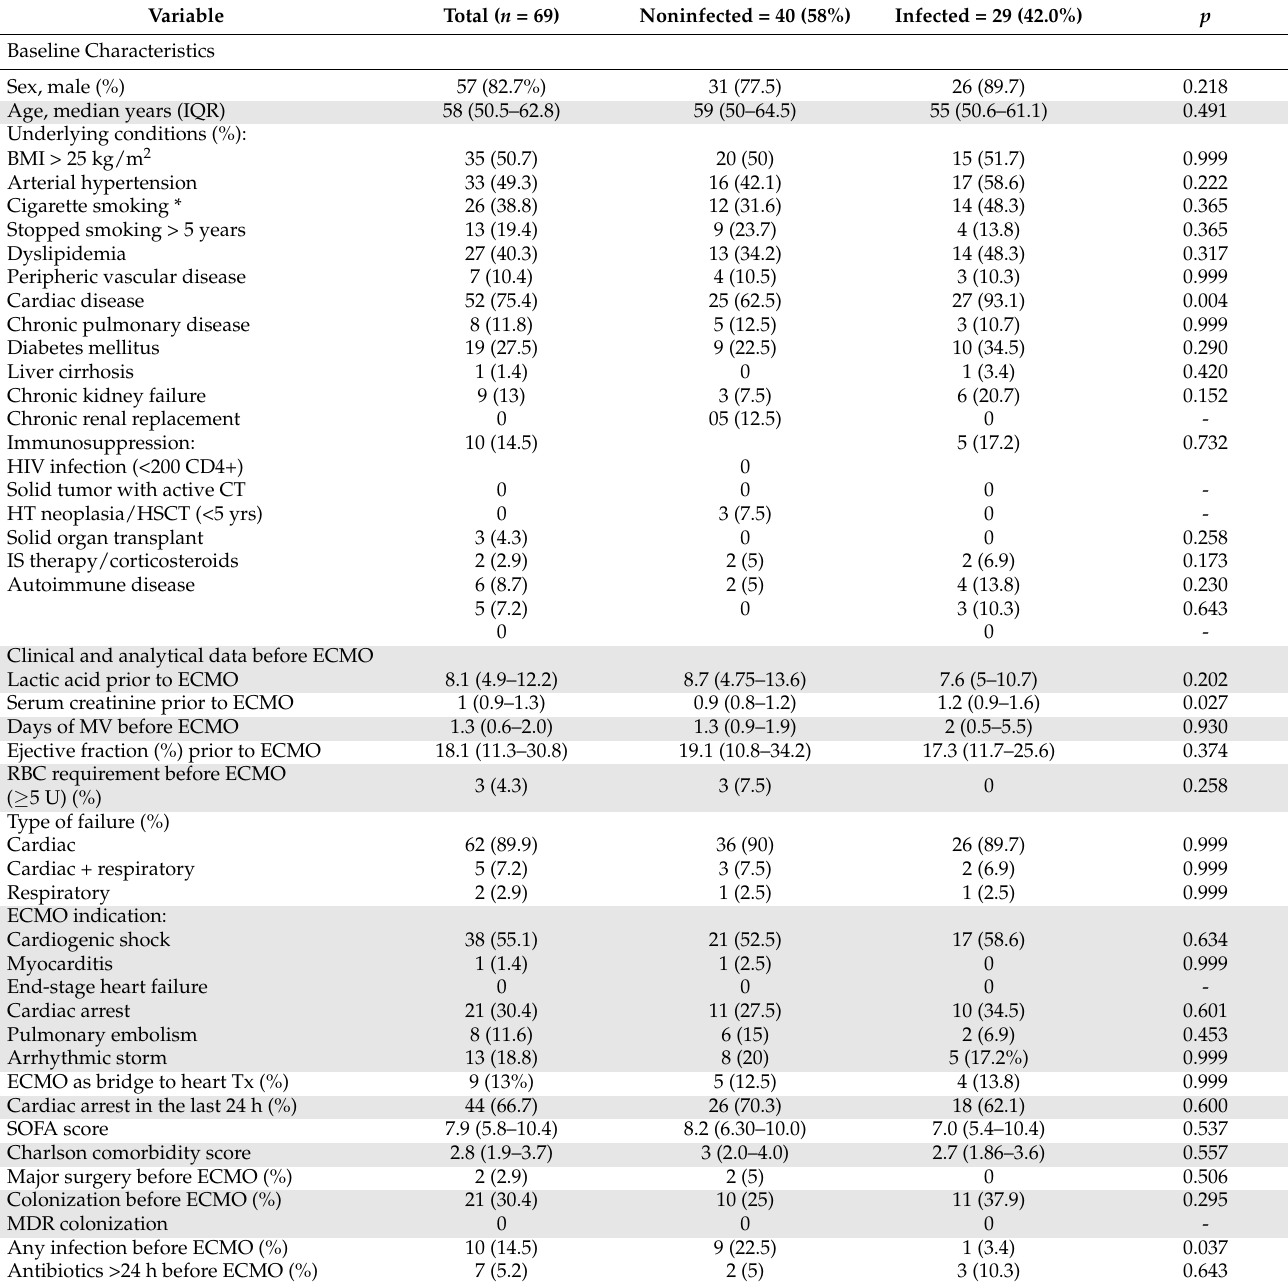
Table 1. Basal characteristics and clinical and analytical data in patients with and without nosocomial